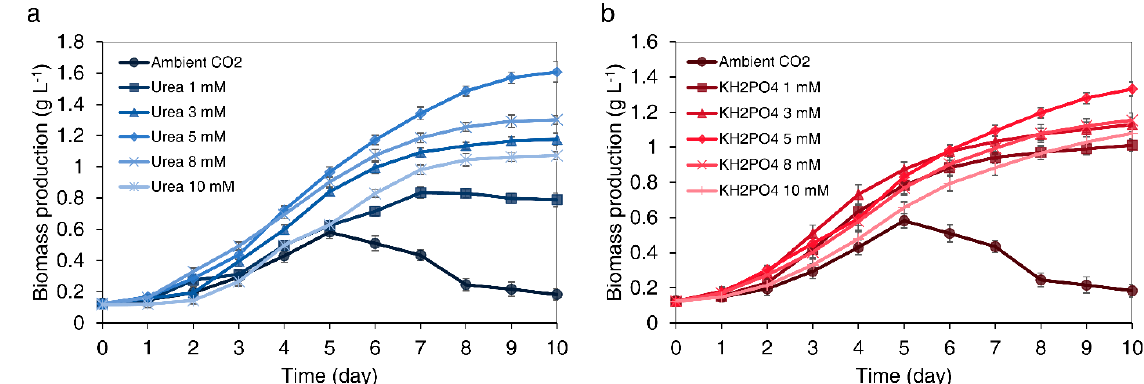
Figure 2. Biomass production of Chlorella sorokiniana UTEX 2714 using chemical fertilizers. Biomass production according to concentrations (0, 1, 3, 5, 8, and 10 mM) of ( a ) urea and ( b ) KH 2 PO 4 injections with ambient CO 2 supply. Results represent the mean ± standard deviation (SD) of three replicates.